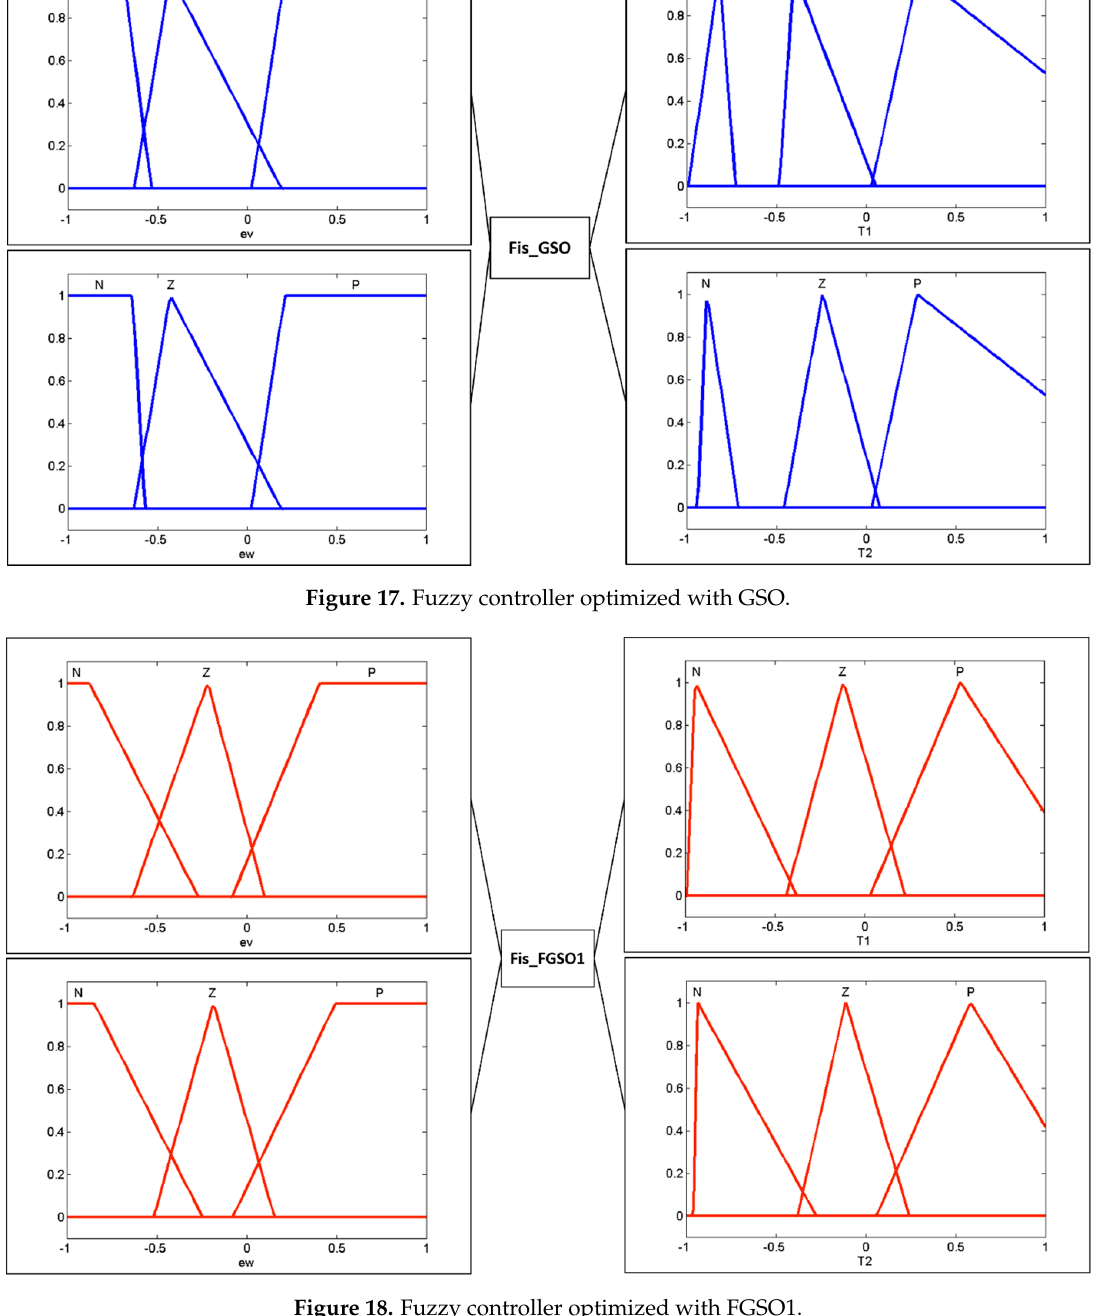
Figure 18. Fuzzy controller optimized with FGSO1.